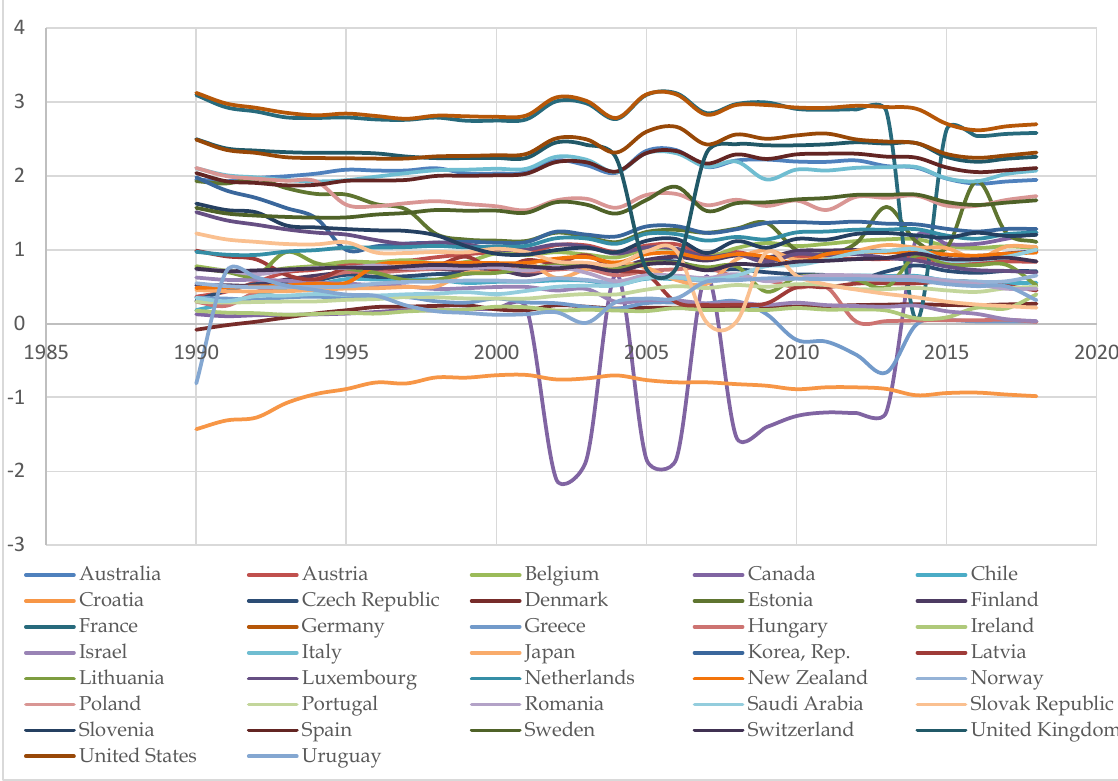
Figure 5. Transportation panel transition paths for High income countries